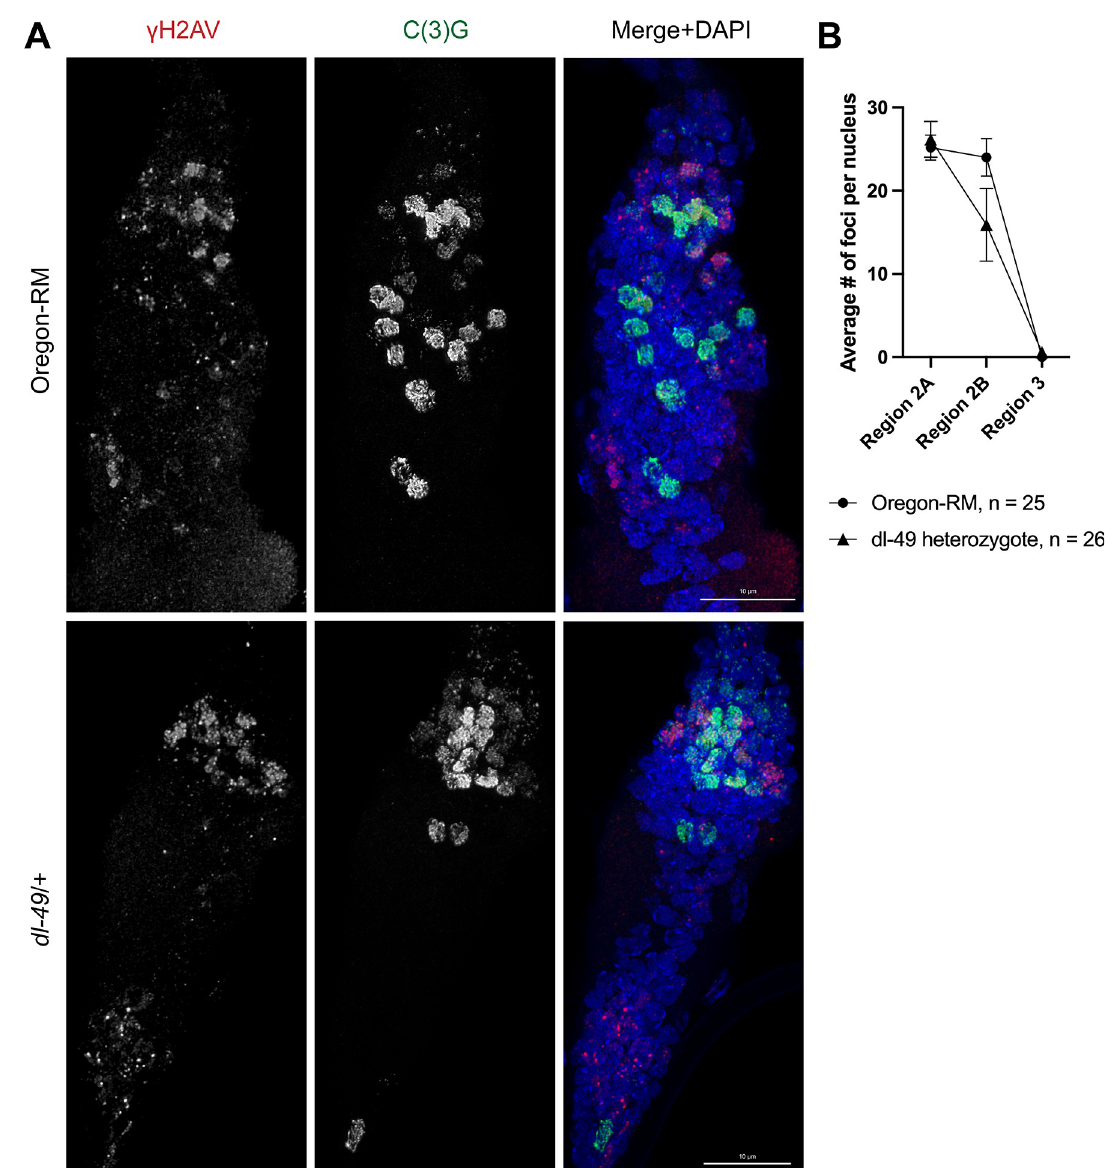
Fig 5. Analysis of phosphorylated H2AV in Oregon-RM and dl-49 heterozygotes. A) Germaria from Oregon-RM and dl-49 heterozygotes were stained with anti-phospho-H2AV, anti-C(3)G, and DAPI. Meiotic nuclei are identified by the presence of C(3)G, a member of the synaptonemal complex. DSBs–marked by phosphorylated H2AV–begin to form in region 2A and are finished being repaired by the time the cyst enters region 3 in wildtype germaria [47]. Note that H2AV is phosphorylated in non-meiotic cells in response to DNA damage. B) Quantitative analysis of DSB timing and number in full sibling Oregon-RM and dl-49 heterozygotes. Average number of foci with the standard error of the mean are shown. A two-way ANOVA with Tukey’s posthoc correction shows that the number of DSBs and the timing of their repair in dl-49 heterozygotes are statistically the same as in Oregon-RM (see main text for details).